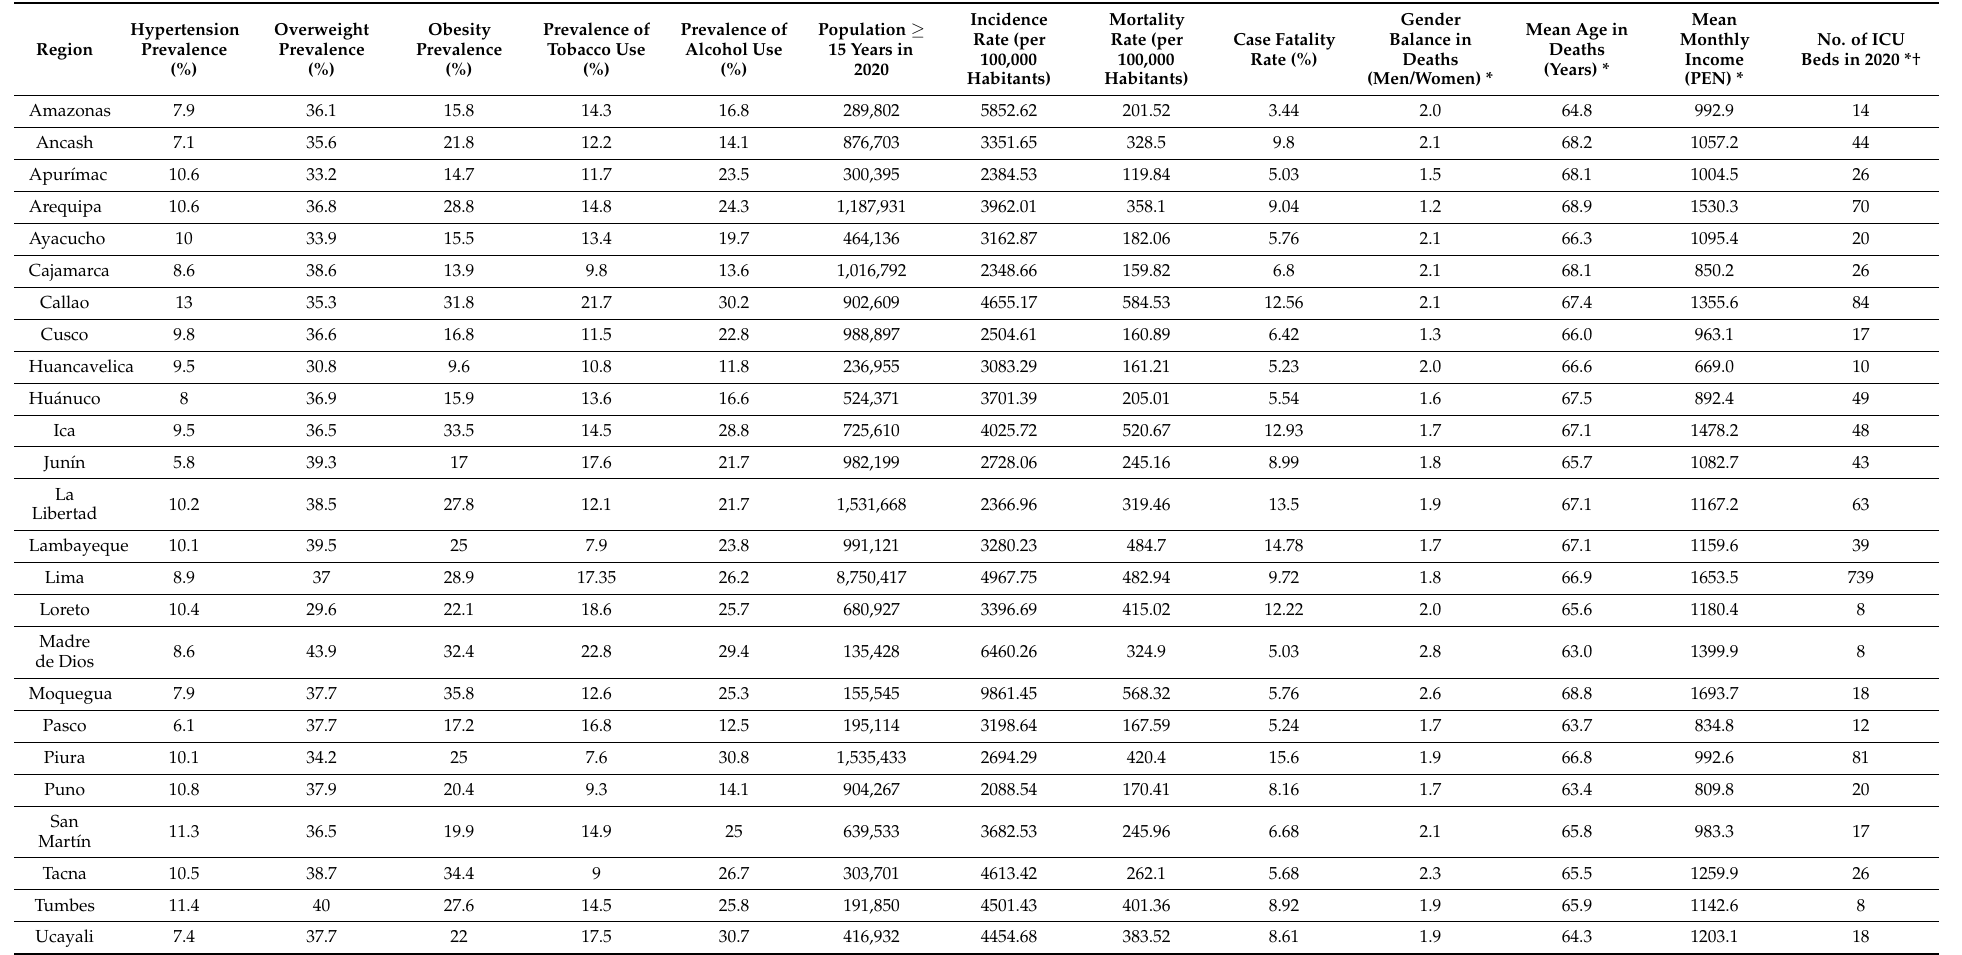
Table 1. Prevalence rates of hypertension, overweight and obesity, smoking, and alcohol use and the incidence, mortality, and fatality rates due to COVID-19 in ≥ 15 year in 25 Peruvian regions in